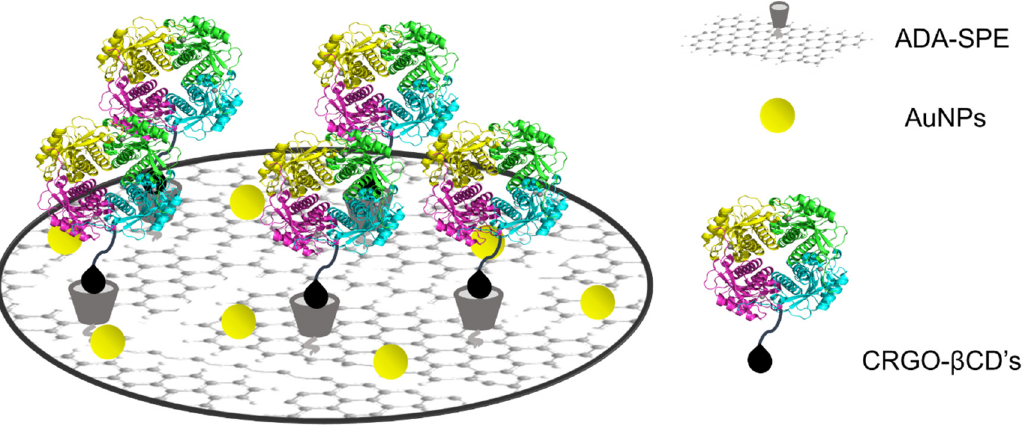
Figure 1. Schematic representation of CRGO- β CD ′ s/ADA-SPE/AuNPs/GCE biosensor for determination of EUG in products of dental use.